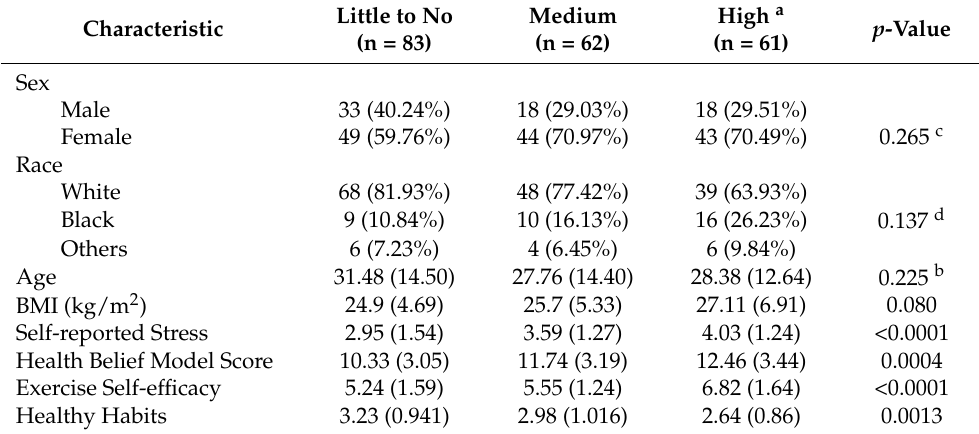
Table 1. Demographic Characteristics of Participants Across Exercise Behavior Change